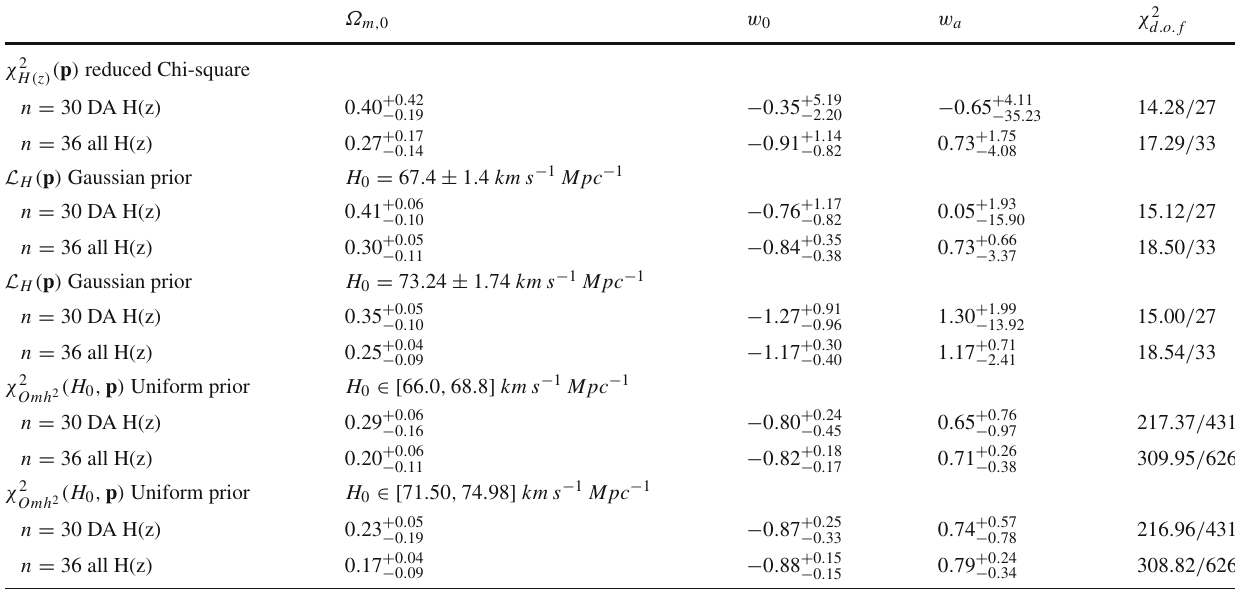
Table 3 Best fitted parameters in CPL cosmological model using H ( z ) data alone and Omh 2 ( z i , z j ) two-point diagnostics. Fits done on dif- ferential ages of cosmic chronometers (DA) and on the full sample